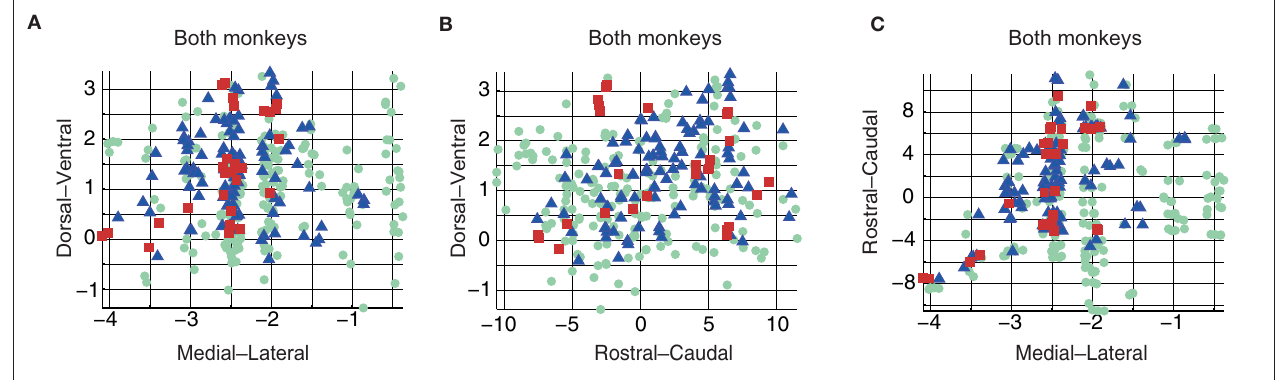
FigUre 5 | Combined results for both monkeys using the K-means method. DV–ML (A) , DV–RC (B) , and RC–ML (C) planes.